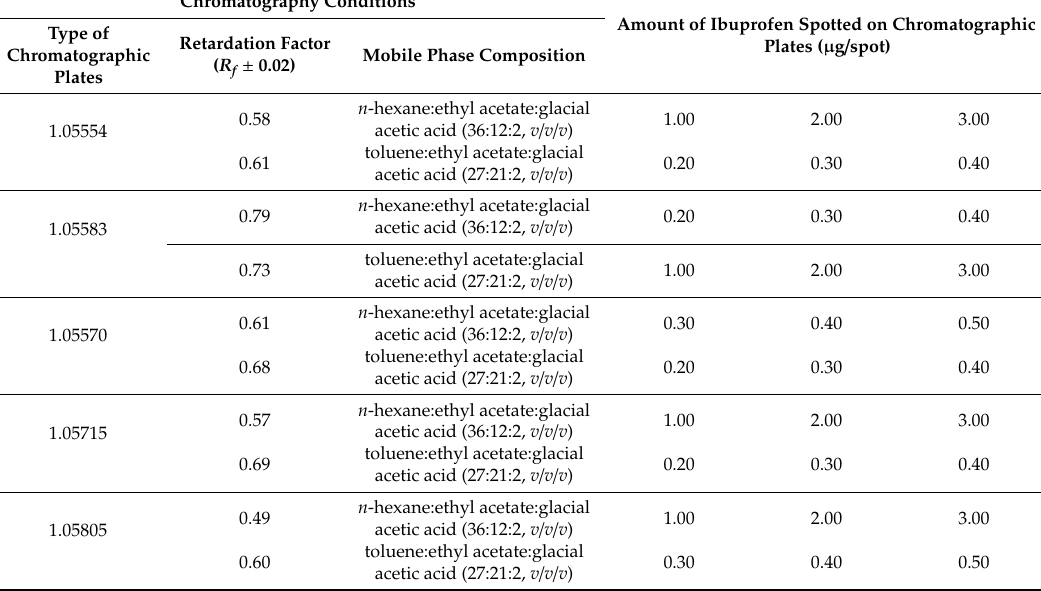
Table 2. Amount of ibuprofen used to prepare specific calibration curves (NP-TLC system). Chromatography Conditions